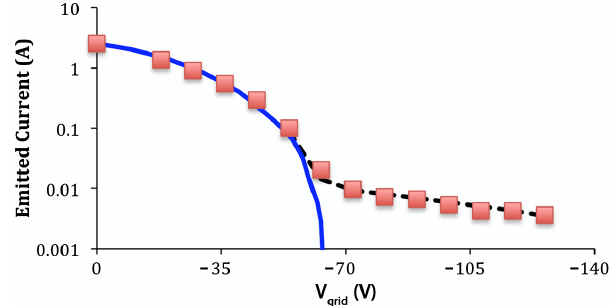
¼ for V grid cathode